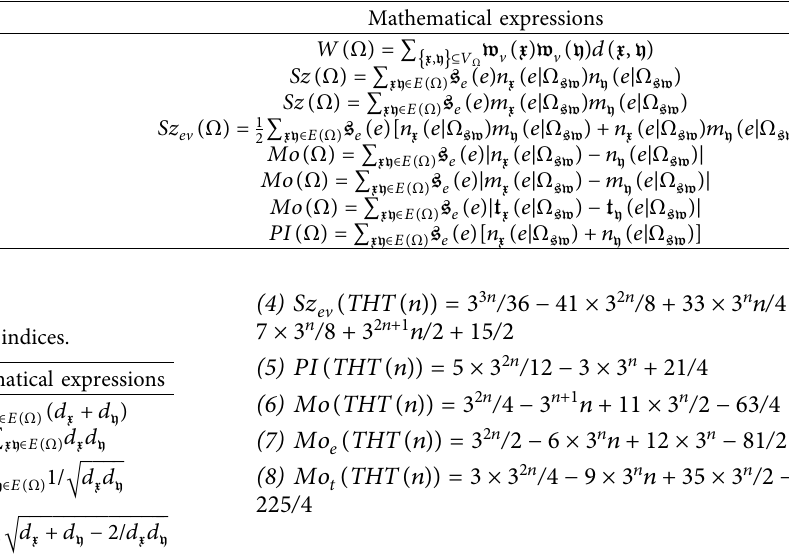
Figure 1: Ternary hypertree of dimension 4. Table 1: Distance-based topological indices.